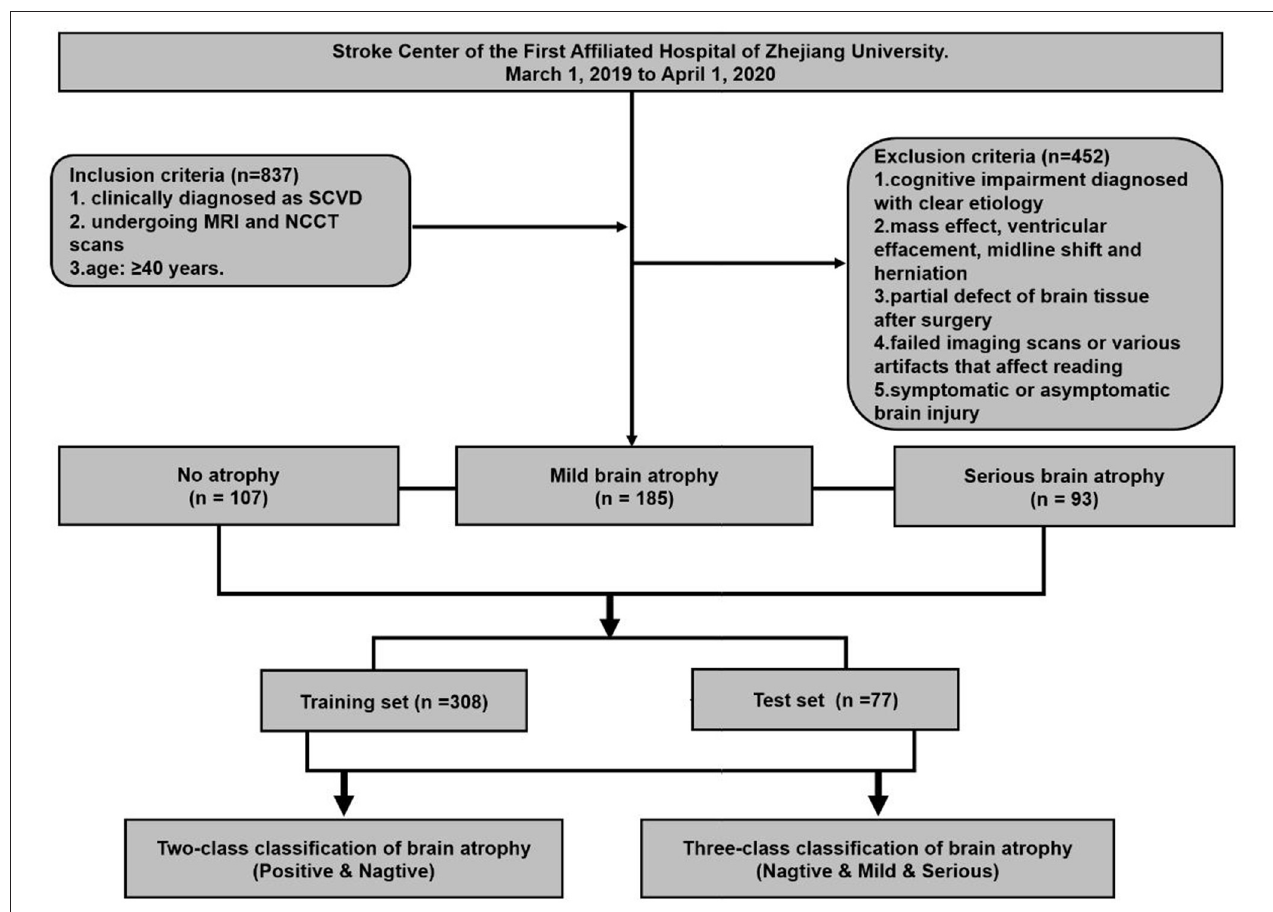
FIGURE 1 | Flowchart of patient enrollment and strategy of training and testing for brain atrophy